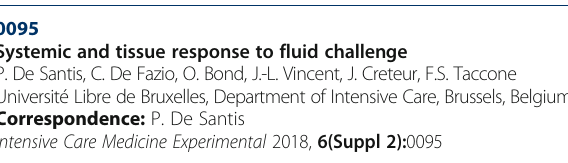
Fig. 2 (abstract 0094). Anova analysis of the considered variables in responders and non